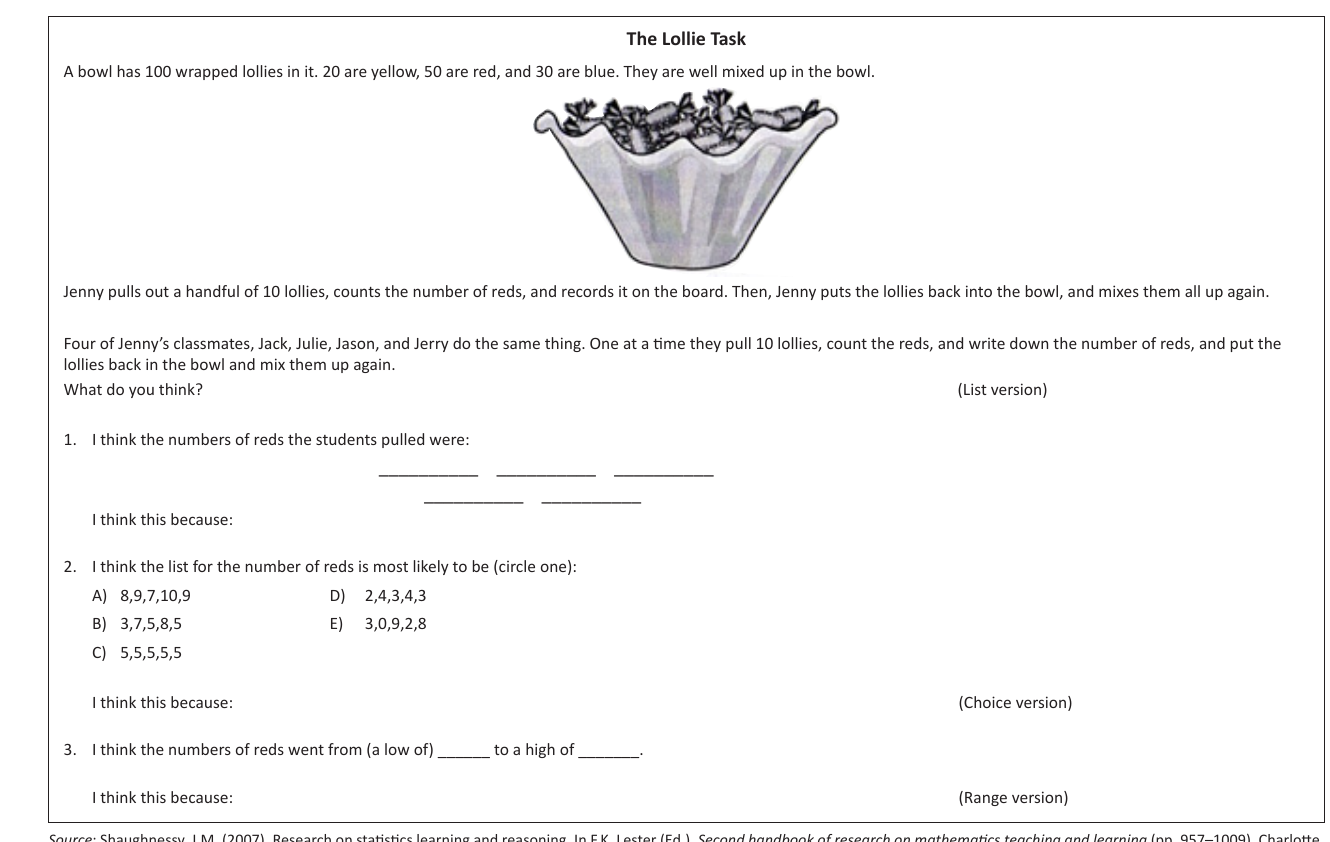
FIGURE 1: The Lollie